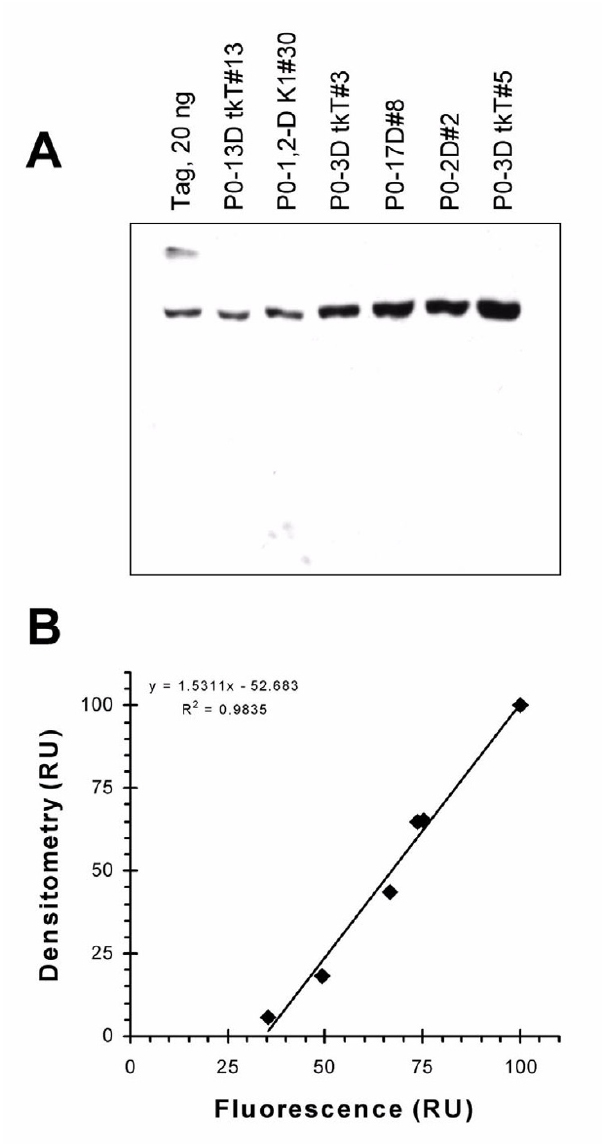
Figure 2 Western blot of Tag expressing cell lines. (A) Cell extracts of each line and a purified baculovirus lysate of recombinant Tag were Western blotted (see Materials and Methods). The P0-13D tkT#13 lane contained lysate from 2.5 × 10 3 cells; for the other lines, lysates from 1.25 × 10 3 cells were loaded. NIH 3T3 extract was added to the low protein extracts and the authentic Tag so that total protein was equal in each lane. (B) Densitometry of the Western blot was compared to total Tag immunofluorescence determined by cytometry for each cell